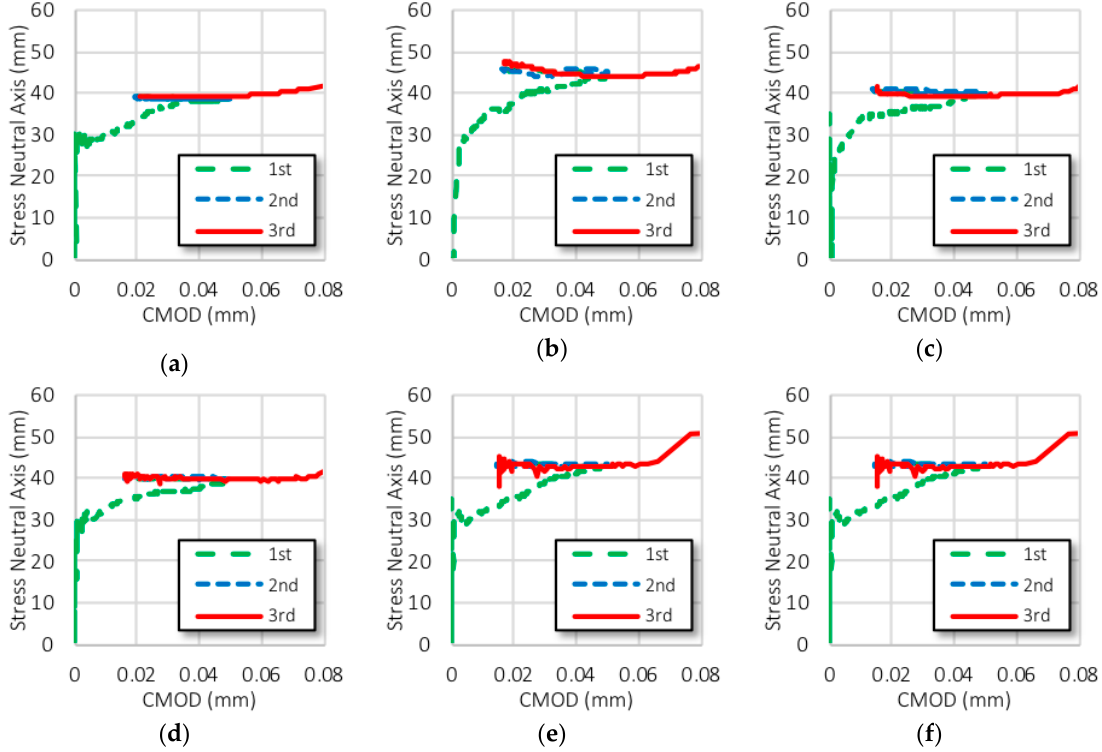
Figure 19. Typical stress neutral axis-CMOD curves for di ff erent crack inducement times. ( a ) 7-28W; ( b ) 28-49W; ( c ) 49-70W; ( d ) 7-28A; ( e ) 28-49A; ( f )